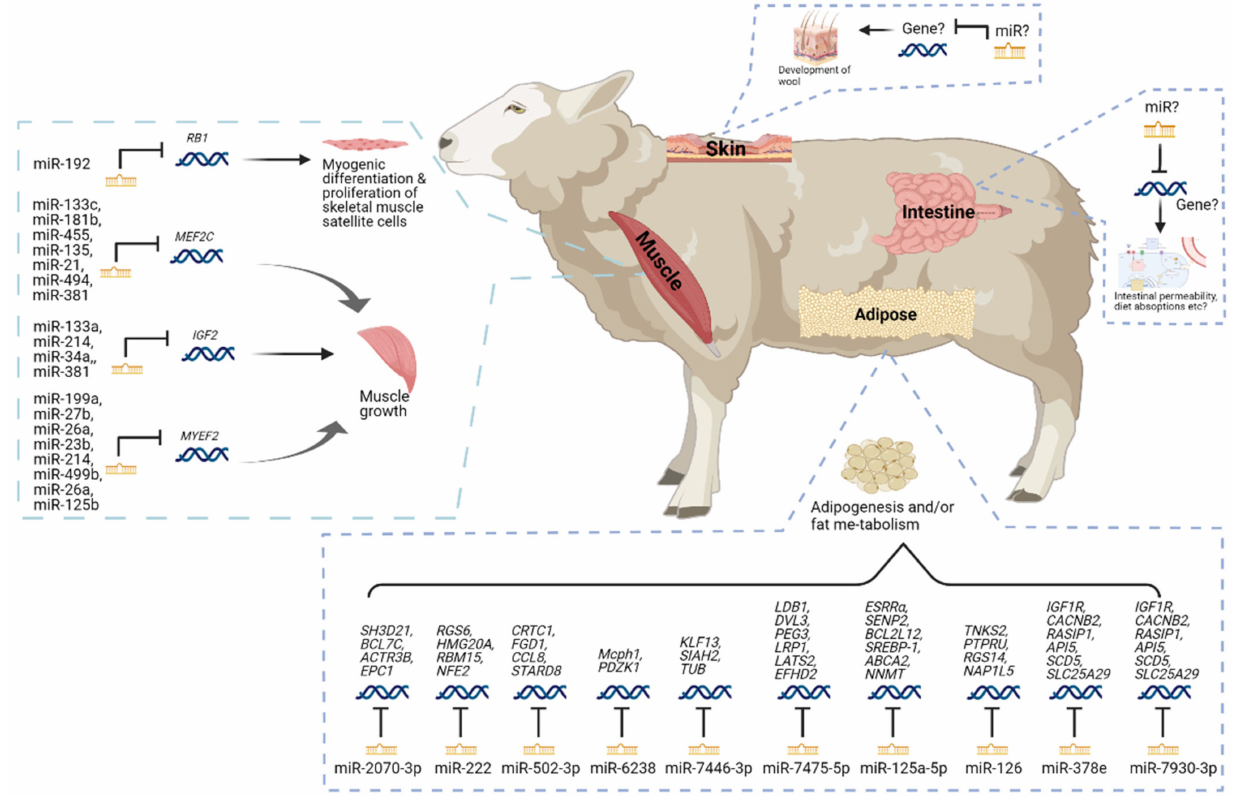
Figure 3. The miRNAs in sheep feed efficiency. This figure was created with BioRender.com